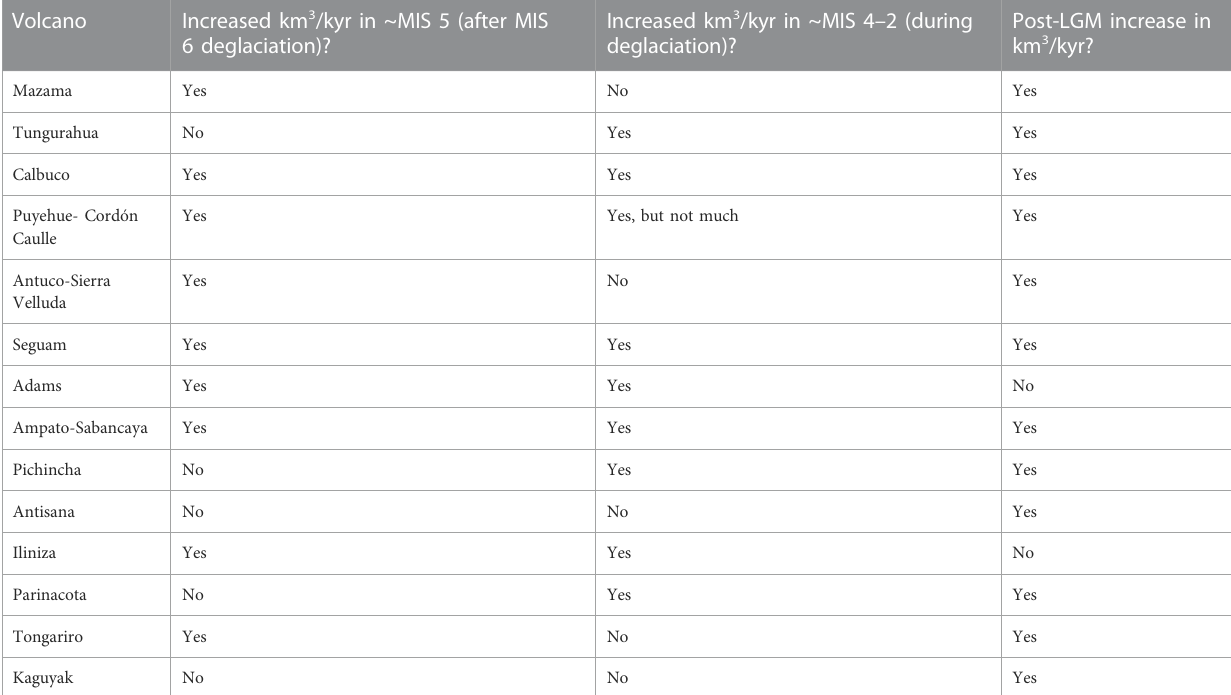
TABLE 3 Summary of changes in edi fi ce growth rates relative to preceding periods as in Figure 3.